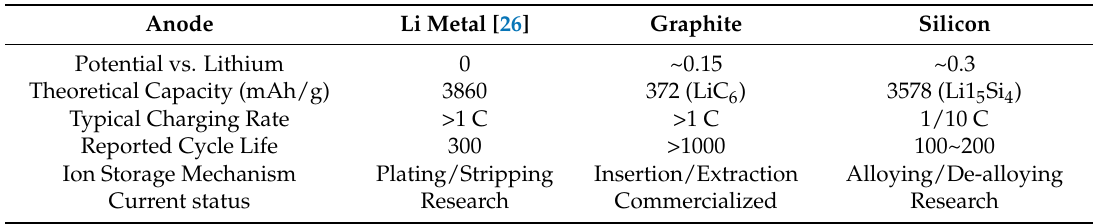
Table 2. Comparison of anode